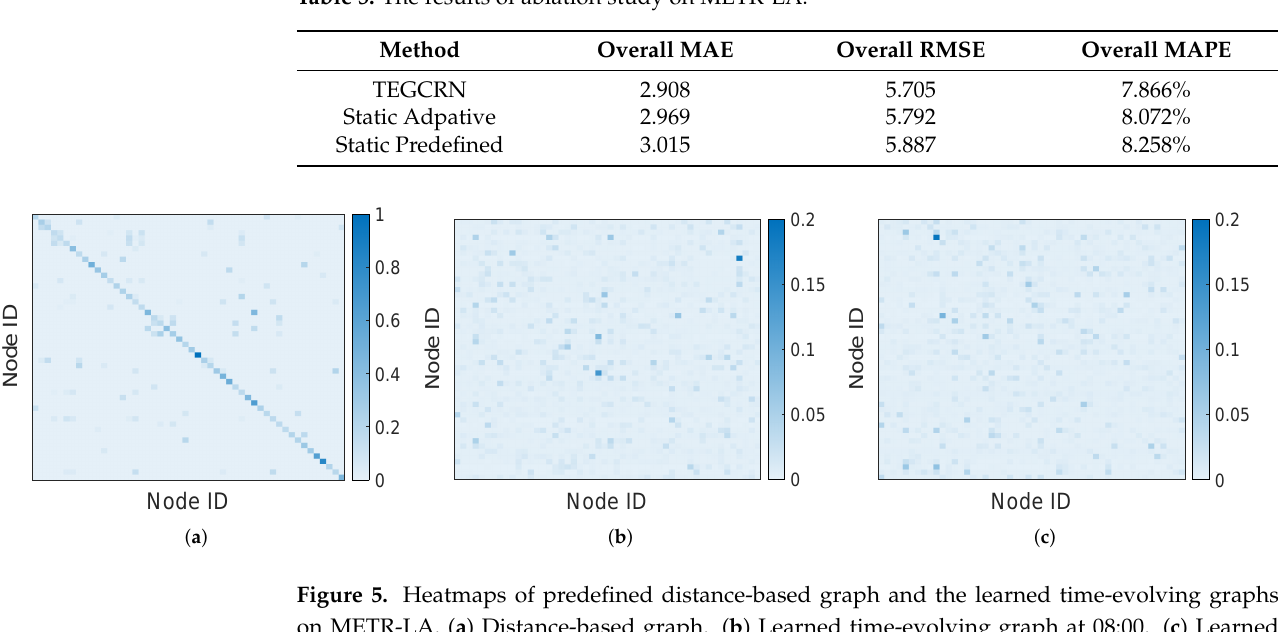
Table 5. The results of ablation study on METR-LA.